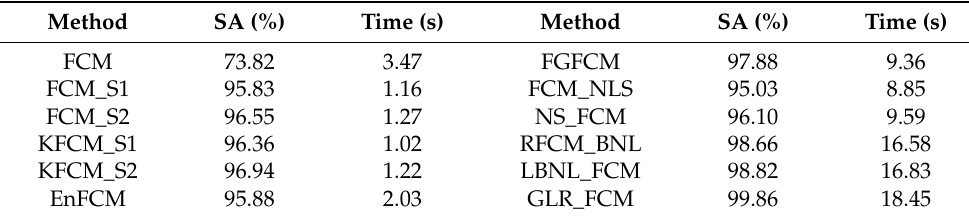
Table 4. SA (%) and executed time(s) on the second simulated SAR